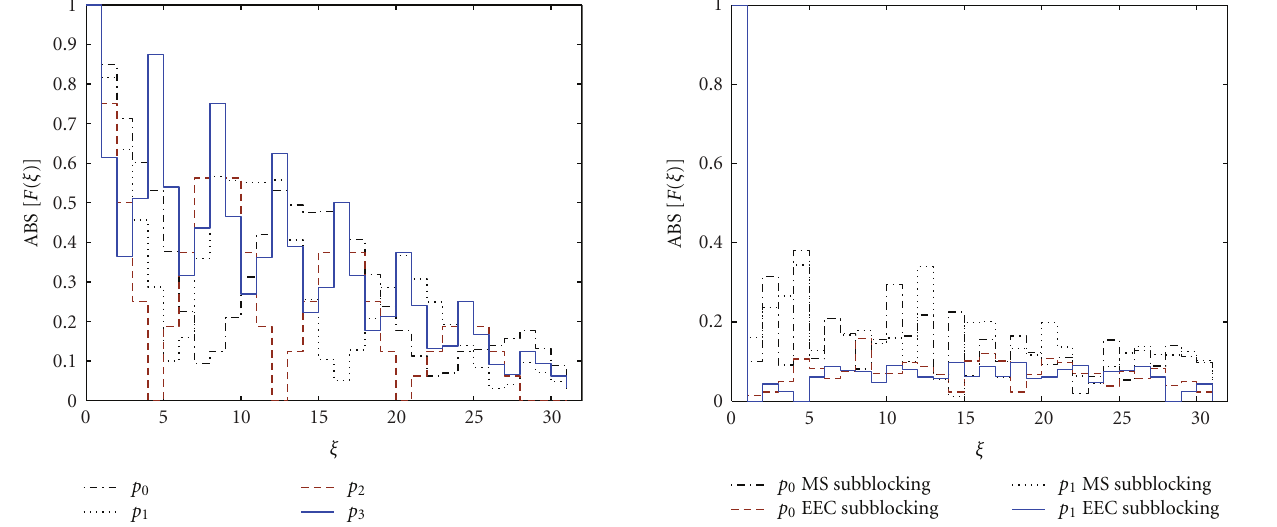
Figure 13: Autocorrelation of the PTS sequences for N = 32, v = 3, P = 4, and r = 2 with repeated subcarriers within each subblock.